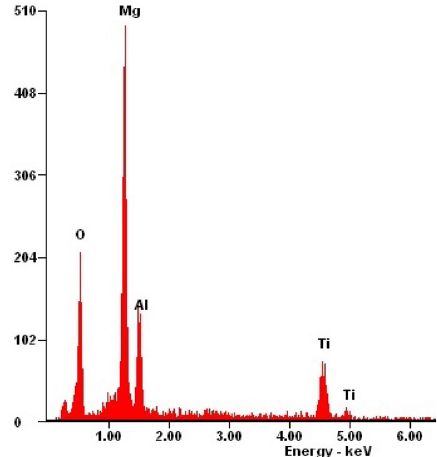
Figure 2. X-ray energy-dispersive plot of the area shown in Fig. 1.